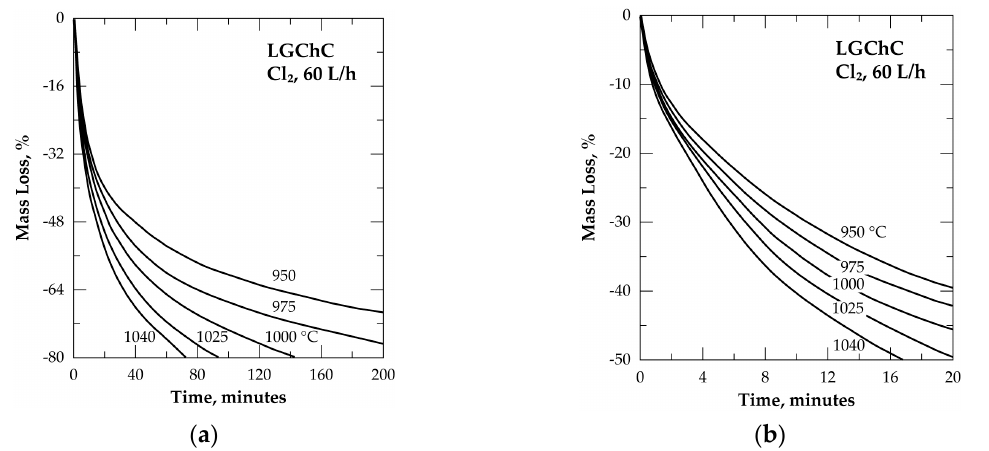
Figure 6. Mass change of the sample versus time for the treatment of LGChC in chlorine from 950 to 1040 °C: ( a ) General view of the obtained isotherms; ( b ) Zoom in on the graph up to 50% ML.